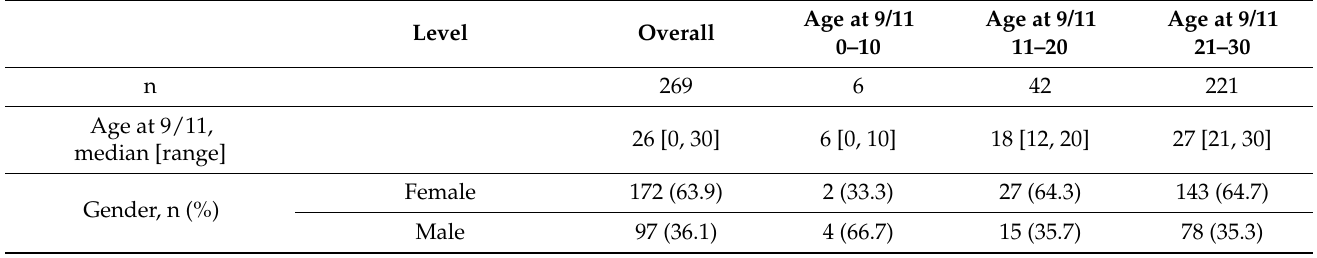
Table 1. Characteristics of EYA with cancer included in the WTC EHC cancer